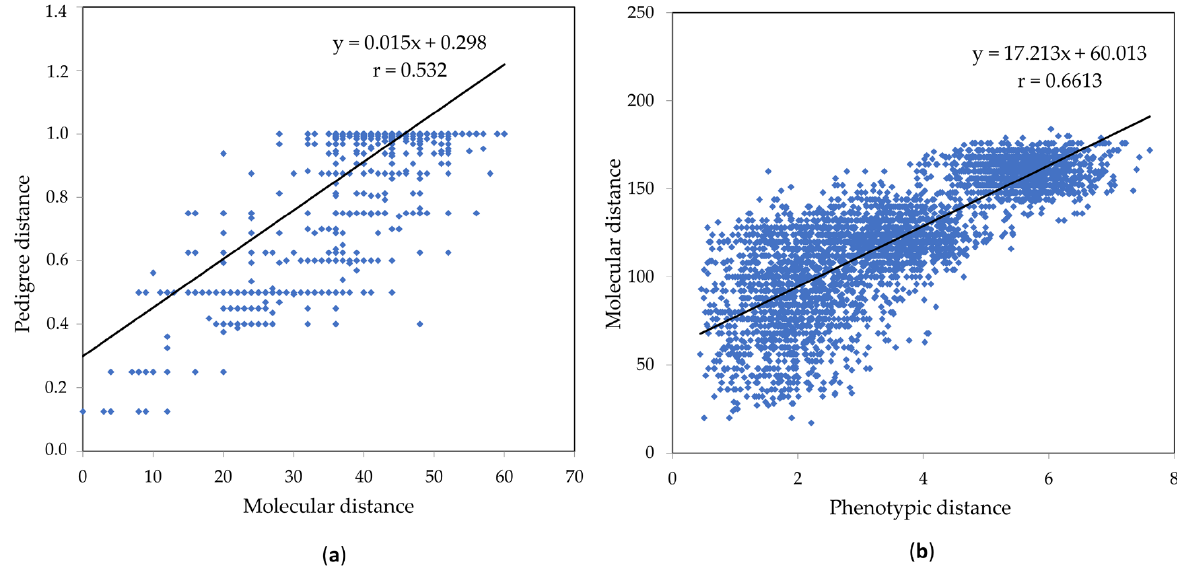
Figure 4. Correlations between molecular and pedigree similarity matrices ( a ) and between phenotypic and molecular similarity matrices ( b ) by Mantel test in GeneAlex 6.5